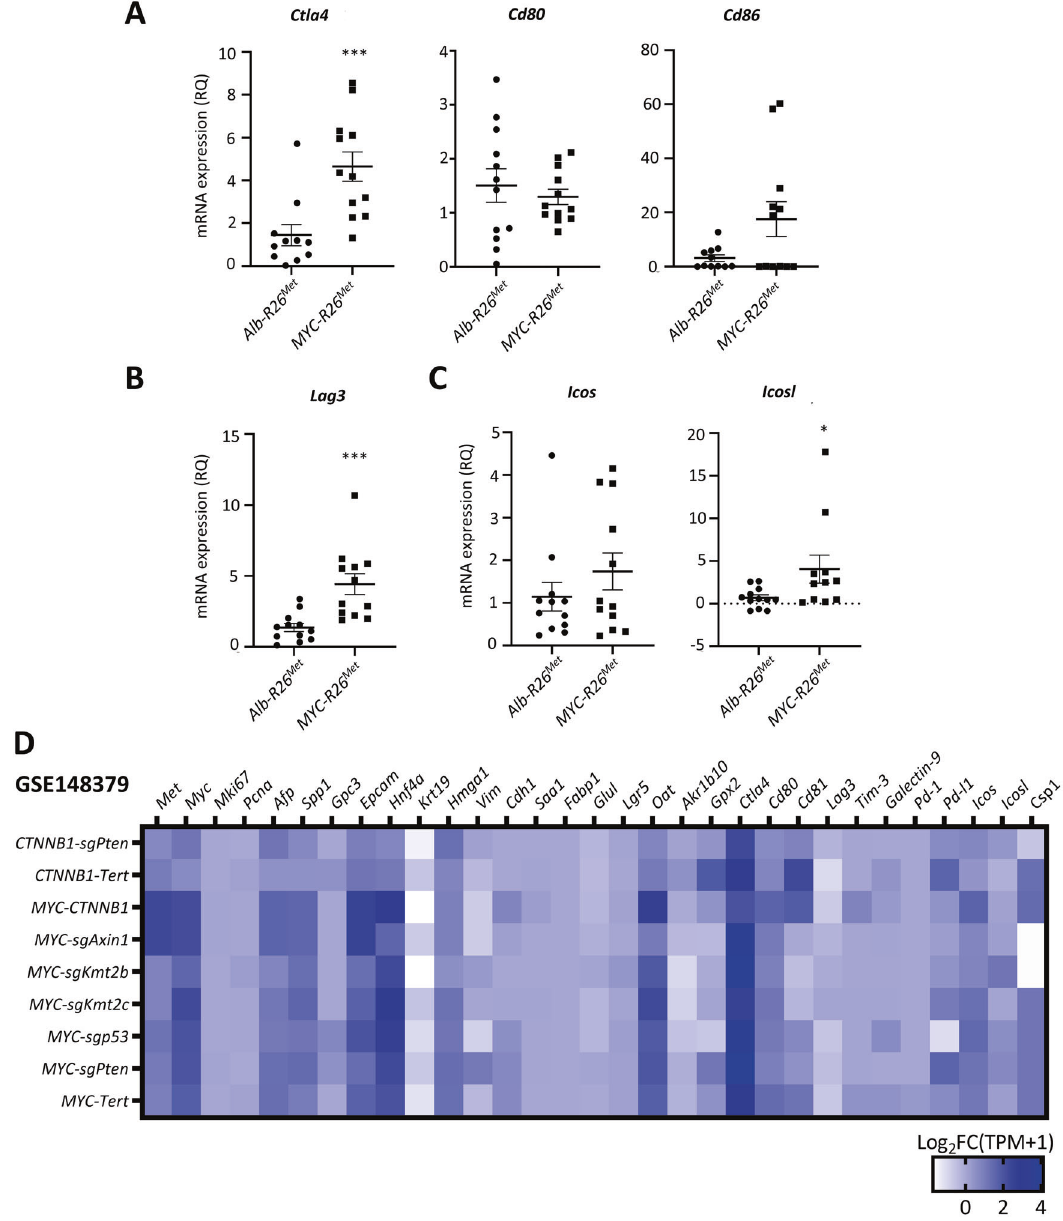
Fig. 5 MYC upregulation switches the immune-related molecular identity of HCC in MET cancer models. A – C Graphs report the mRNA expression levels by RT-qPCR of the immune checkpoints Ctla4 and its ligands Cd80 and Cd81 ( A ), Lag3 ( B ), Icos and its ligand Icosl ( C ). D Heatmap representing the mRNA levels of genes of interest (indicated on the top) expressed as Log 2 FC (TPM + 1) in different tumours from murine HCC models obtained by hydrodynamically injecting plasmids to overexpress MYC in combination with different oncogenes (indicated on the left), compared with control livers. Results were extracted from a publicly available database with the GEO accession number